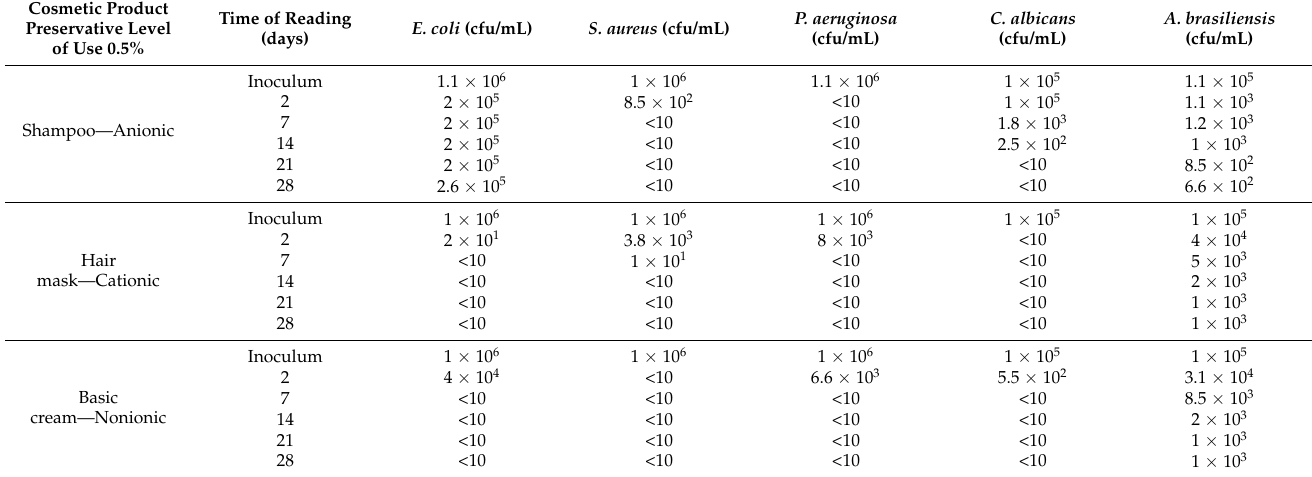
Table 6. Challenge test of classical preservative mixture (0.5%) composed of Ethylhexylglycerin and Phenoxyethanol (14/81) with addition of 5% Didecyldimethylammonium chloride in three different cosmetic formulations: shampoo (based on anionic surfactants), hair mask (cationic) and basic cream (nonionic) as described in Figure 2. Cosmetic Product Preservative Level of Use 0.5%